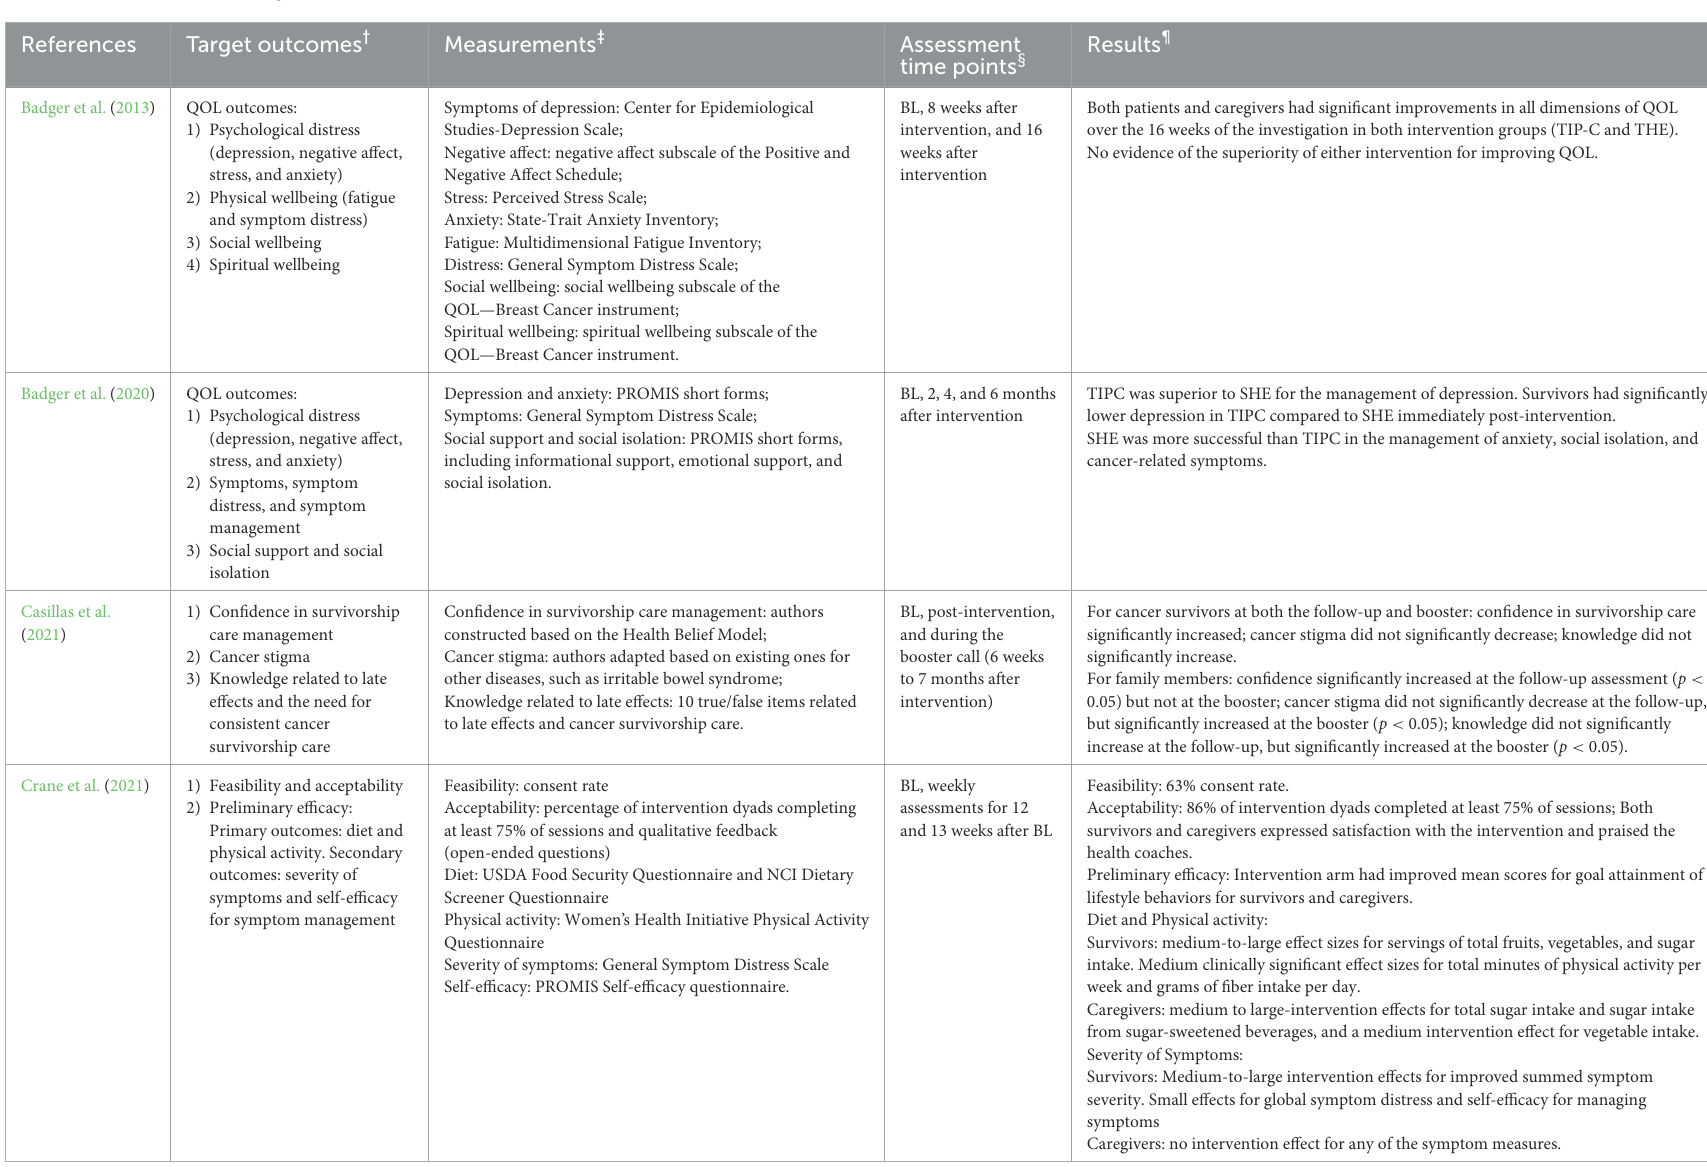
TABLE 4 Measurements and study